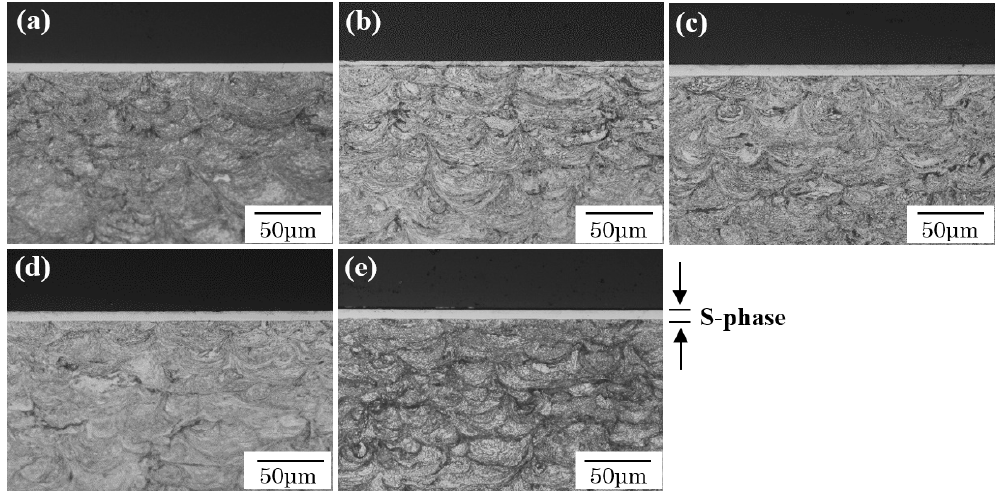
Figure 3. Cross-sectional micrographs of the S-phase layers on cold-sprayed AISI 316L coatings obtained at 400 °C by ( a ) carburizing for 4 h, ( b ) nitriding for 4 h, ( c ) C0.5 h → N3.5 h, ( d ) C2 h → N2 h, and ( e ) (C+N)4 h.